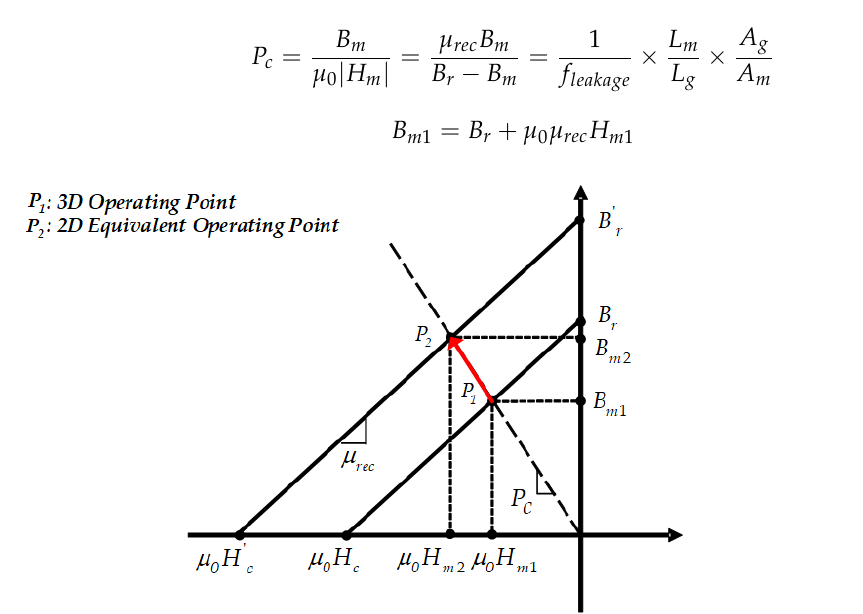
Figure 2. Demagnetization curve of a PM.